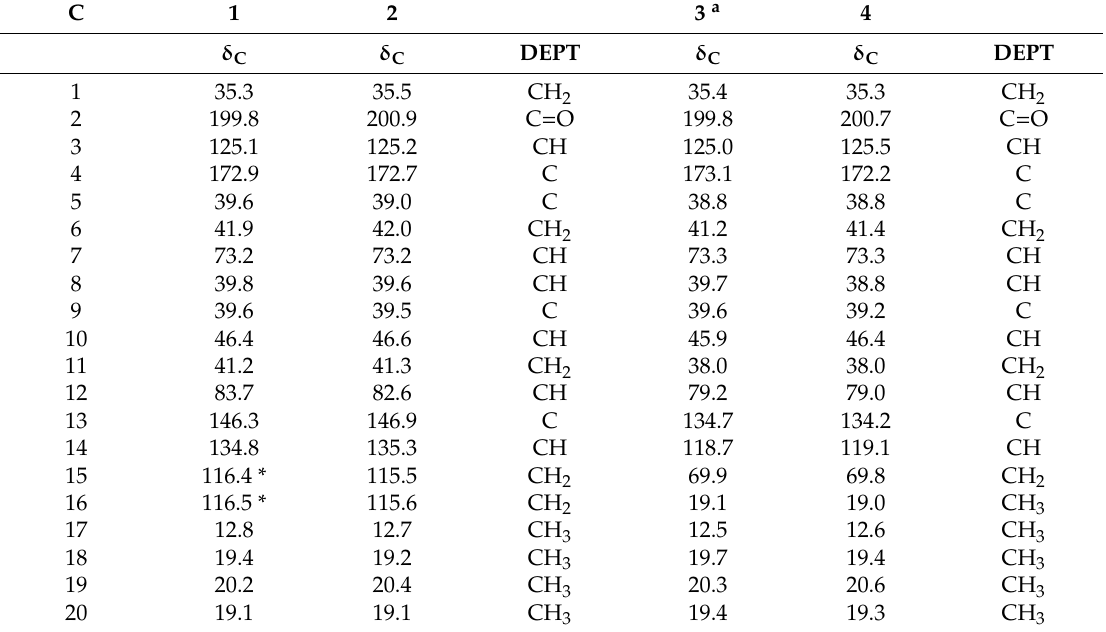
Table 2. The 13 C NMR data assignments for compounds 1 - 4 (150 MHz, in CDCl 3 ) a